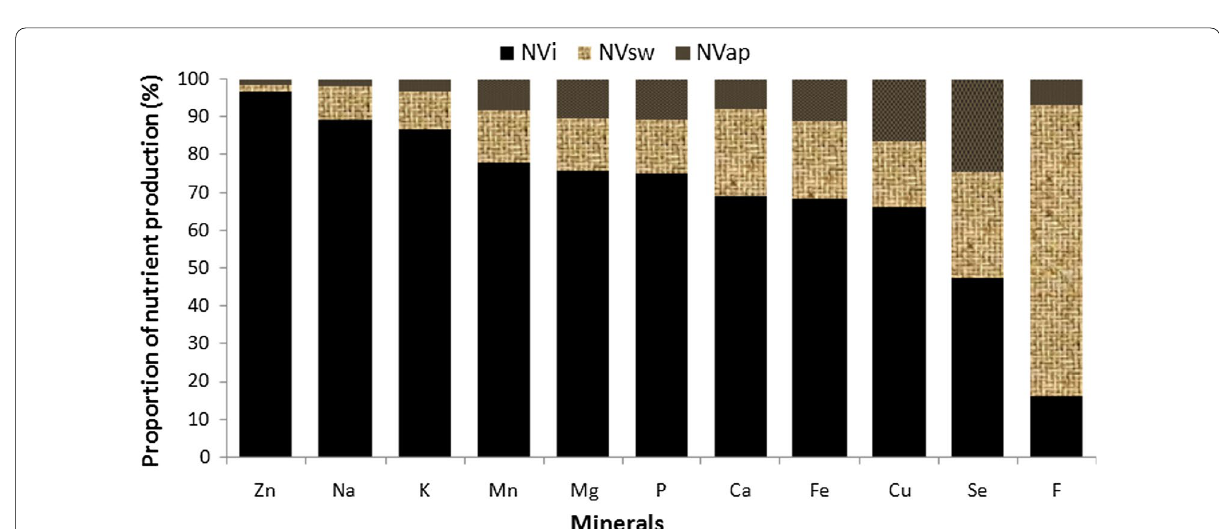
Fig. 2 Proportion of minerals attributed to pollinator-independent crops, self- or wind pollination and animal pollination. Zn K potassium, Mn =